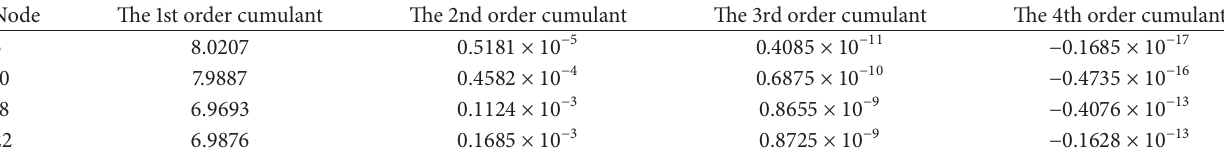
Table 4: Moment of bus voltage in case 3.